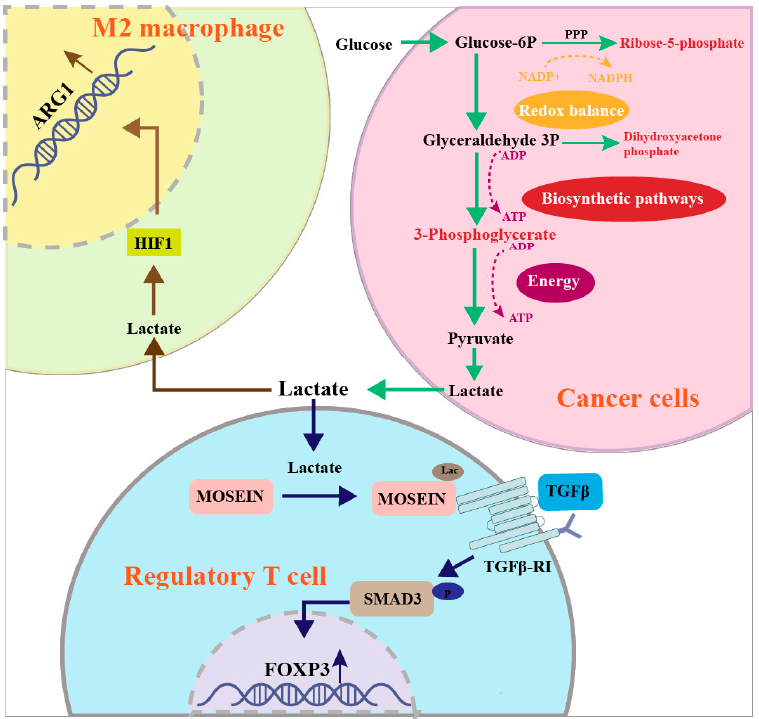
Figure 1. Increased glycolysis contributes to GI cancer progression. Increased glycolysis produces large amounts of ATP and NADH, as well as the raw materials for the biosynthesis of macromolecules required to support uncontrolled cell proliferation. Increased glycolysis also yields abundant lactate, which mediates immunosuppression by inducing M2 phenotype macrophage differentiation and enhancing the function of regulatory T